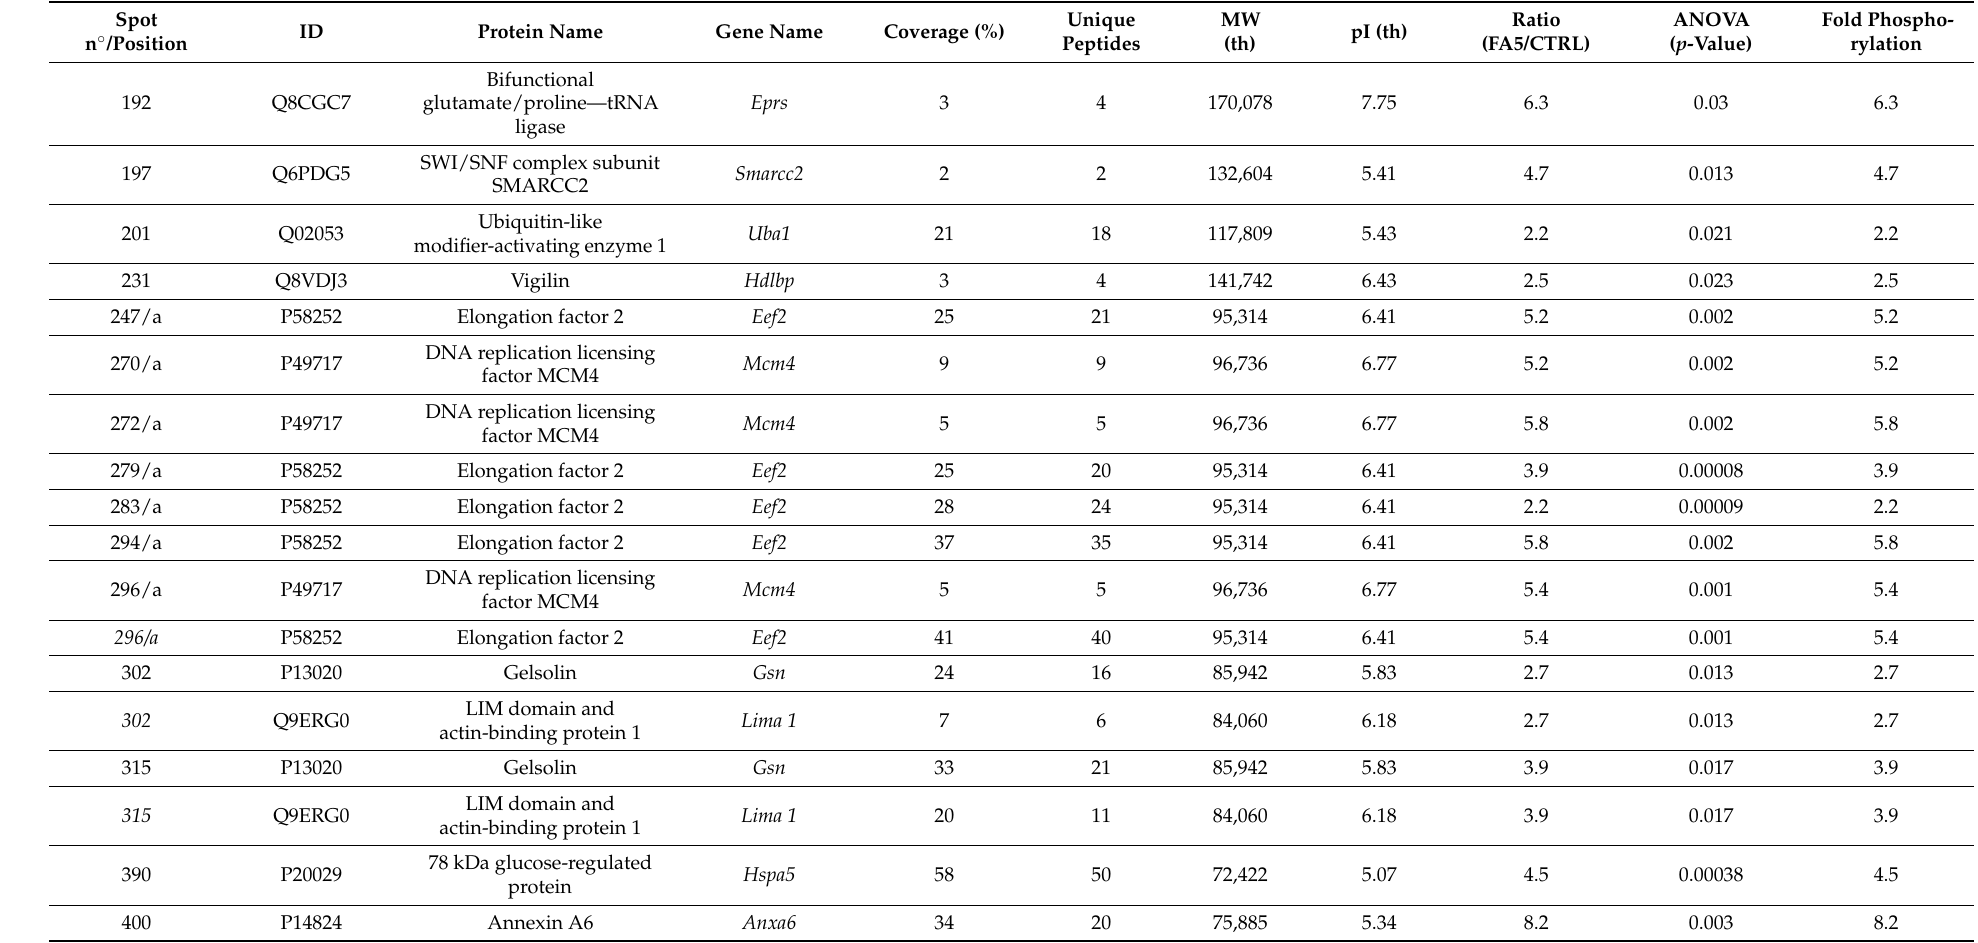
Table 1. List of the differentially phosphorylated protein spots identified by